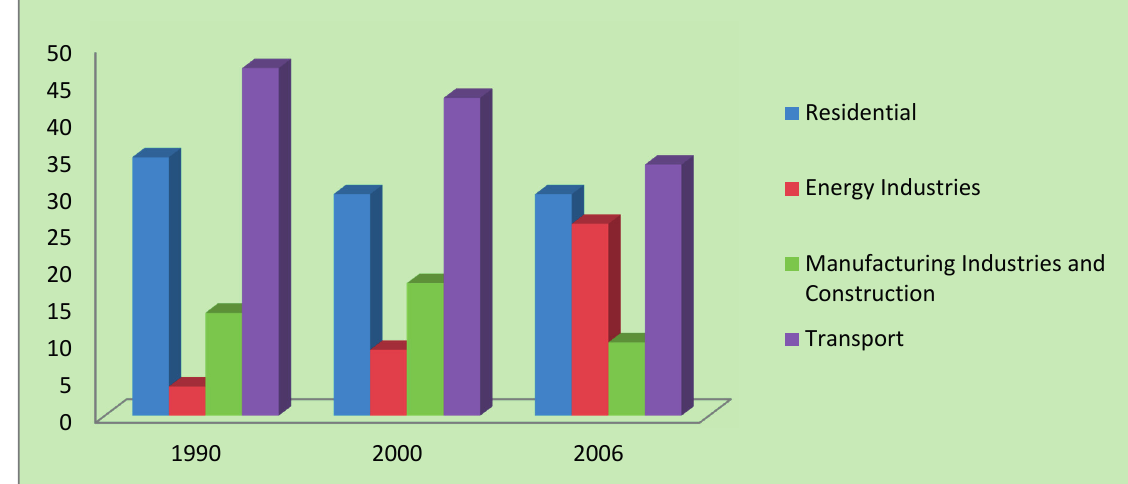
Figure 3. Constituent of Emissions in the Energy Sector. Source: Authors’ compilation from